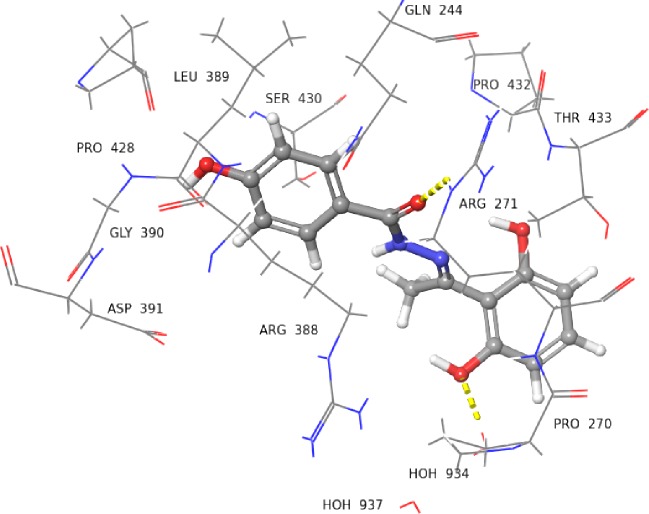
3D Representation view of docked pose of compound 27 (IC50 = 176.9 ± 1.6 μM).The carboxyl group of hydrazide is interacting with Arg271 via H-bond (yellow dotted lines), while the ortho substituted OH group is interacting with Pro270 via H-bond (blue dotted lines).